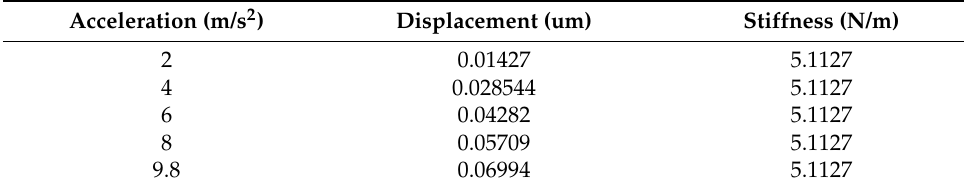
Table 2. Static force analysis (double-stage beam).